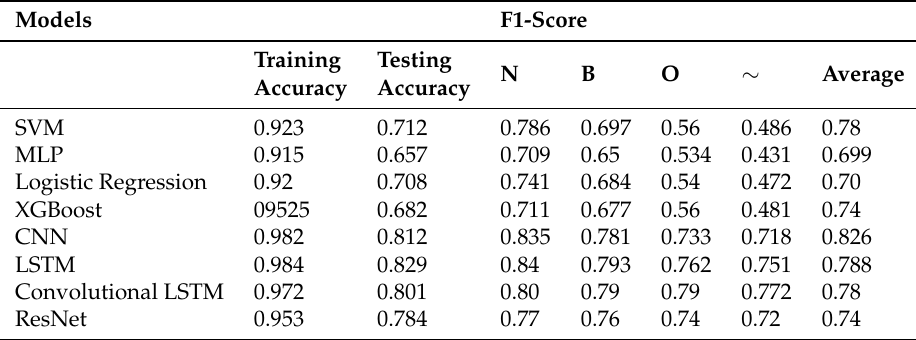
Table 4. Summary of ML and DL classifiers MIT-BIH Atrial Fibrillation.